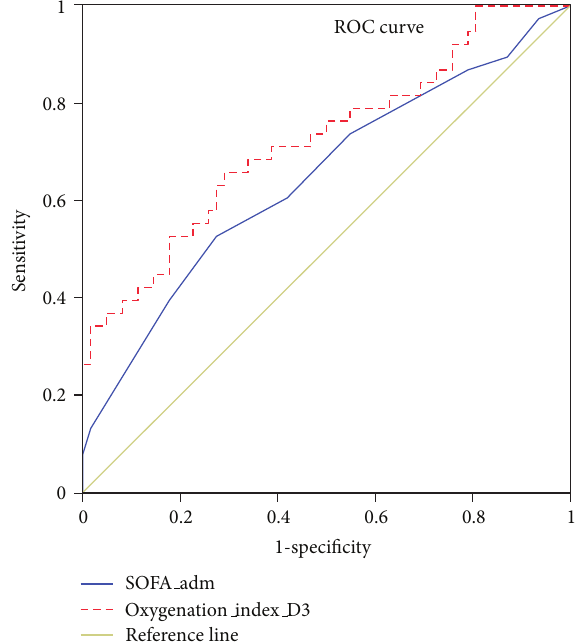
Figure 1: ROC curve analysis for predictability of hospital mortality between Day 3 OI and SOFA